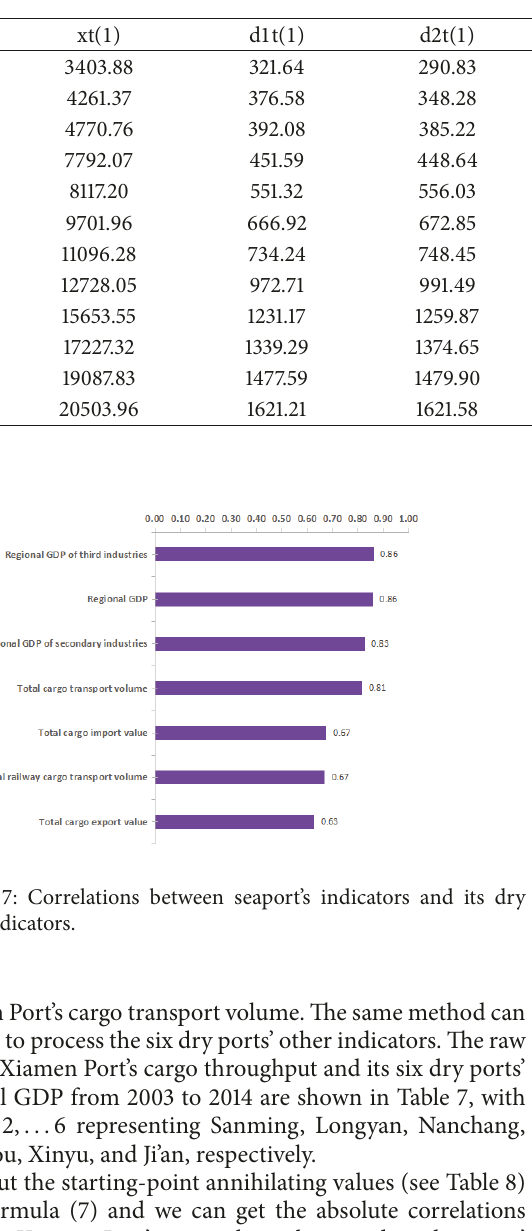
Table 7: Raw data of Xiamen Port’s cargo throughput and its dry ports’ regional GDP.